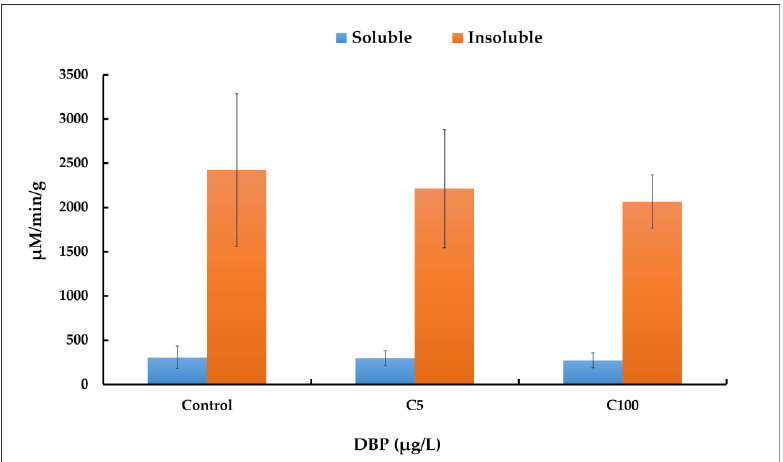
Figure 1. AChE activity in zebrafish ( D. rerio ) larvae exposed to different concentrations of DBP (0 or control, 5 and 100 µ g/L noted, respectively C5 and C100) for 5 days. Measurements were performed on the soluble and insoluble protein fractions. Results are the mean ± SD of replicate samples. For controls, AChE activity was 307 µ M/min/g ( ± 127) and 2422 µ M/min/g ( ± 863) for soluble and insoluble fractions, respectively. A t -test was used to determine statistical differences between experimental groups, with p < 0.05 considered as significant.